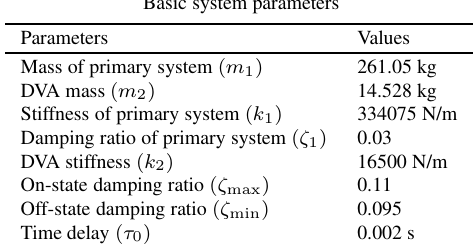
Table 1 Basic system